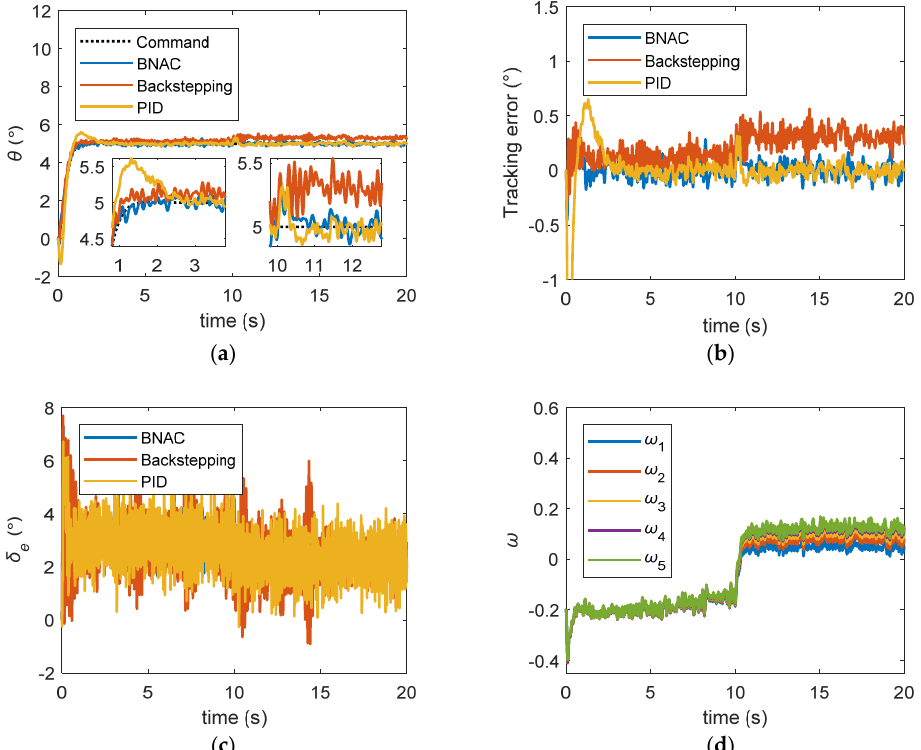
Figure 9. Step signal tracking results under external disturbance and noise: ( a ) pitch angle trajectory; ( b ) tracking error; ( c ) elevator deflection; ( d ) RBF NN weights.